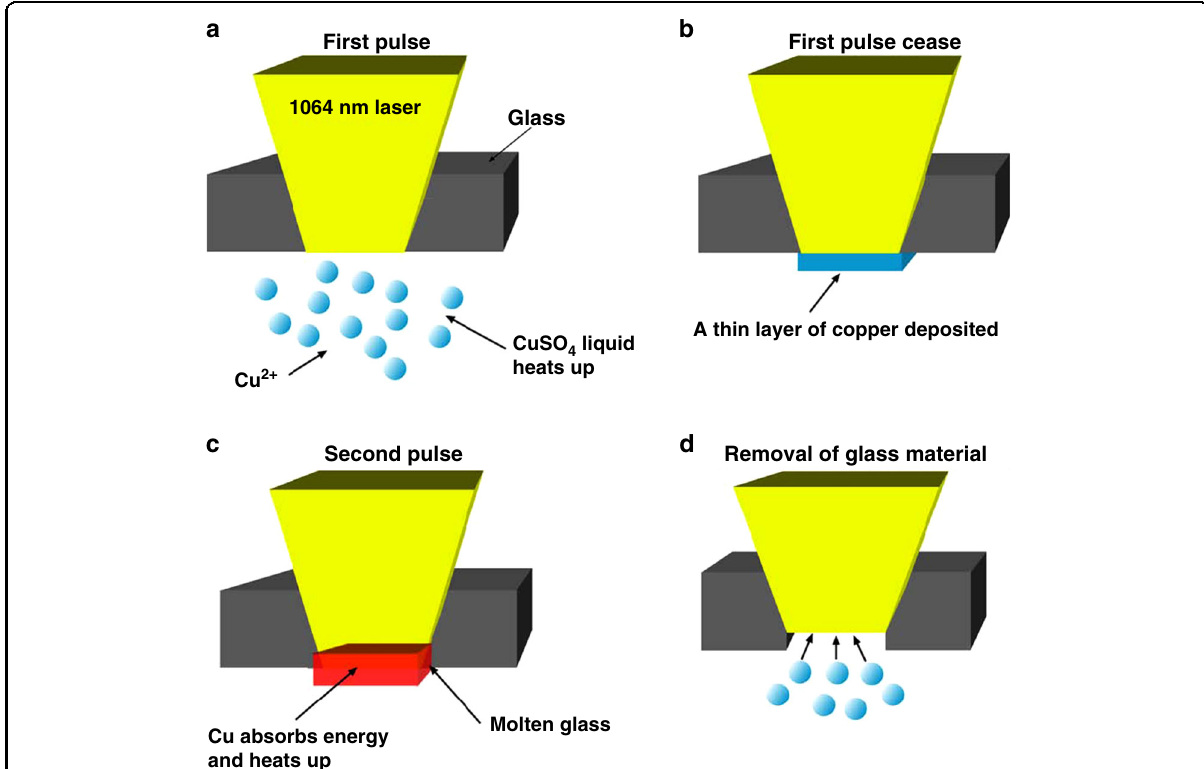
Fig. 9 Proposed mechanism of LIBWE using 1064nm laser and CuSO 4 solution as the liquid absorber 73 . a Laser irradiates from the top. b Copper deposition on the backside of the glass. c The deposited copper absorbs the laser energy and heats up the immediate glass region. d Removal of the molten substrate. Reproduce with permission from ref. 74 , © Springer-Verlag